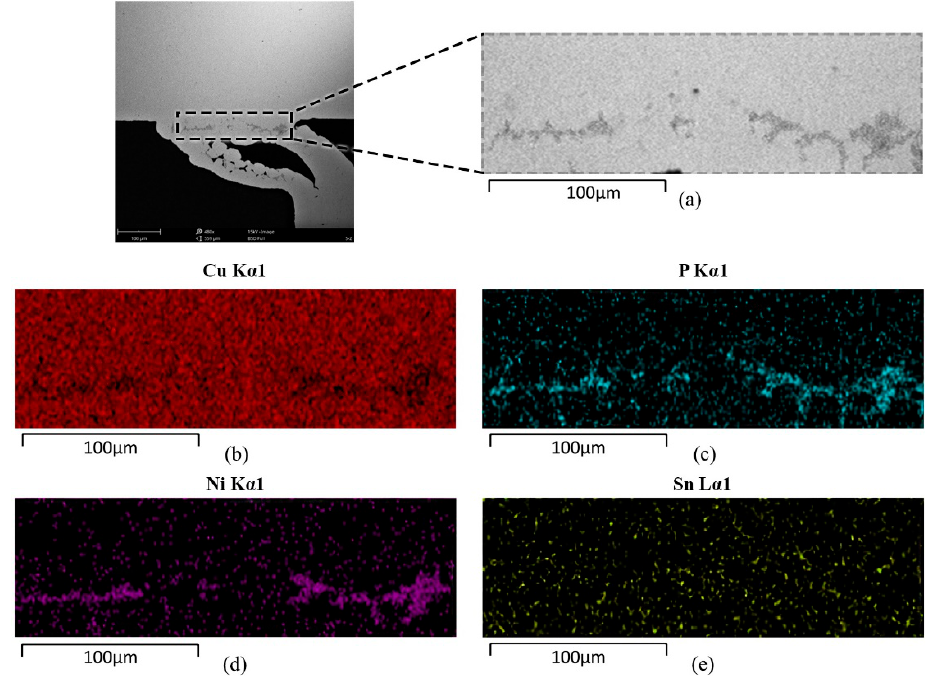
Figure 5. Map analysis of joint interface brazed at 680 °C for 10 min: ( a ) SEM micrograph of the top of the joint; and element analysis of ( b ) Cu, ( c ) P, ( d ) Ni, ( e ) Sn.